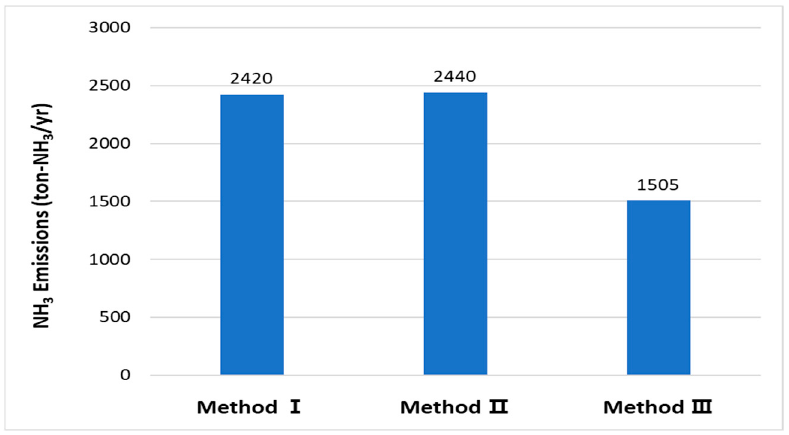
Figure 7. Comparison of NH 3 emissions in fertilizer application by calculation method.